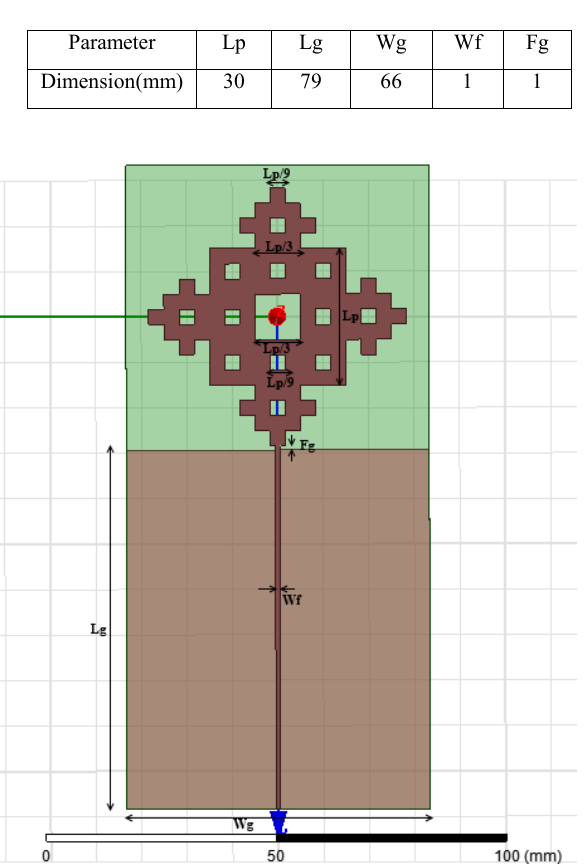
Figure 2: Proposed hybrid fractal shaped antenna